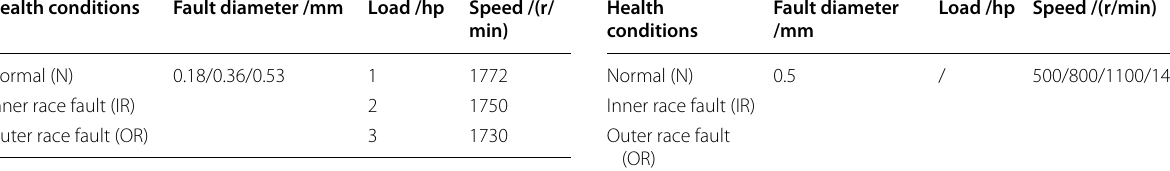
Table 1 Details of the CWRU bearing dataset Health conditions